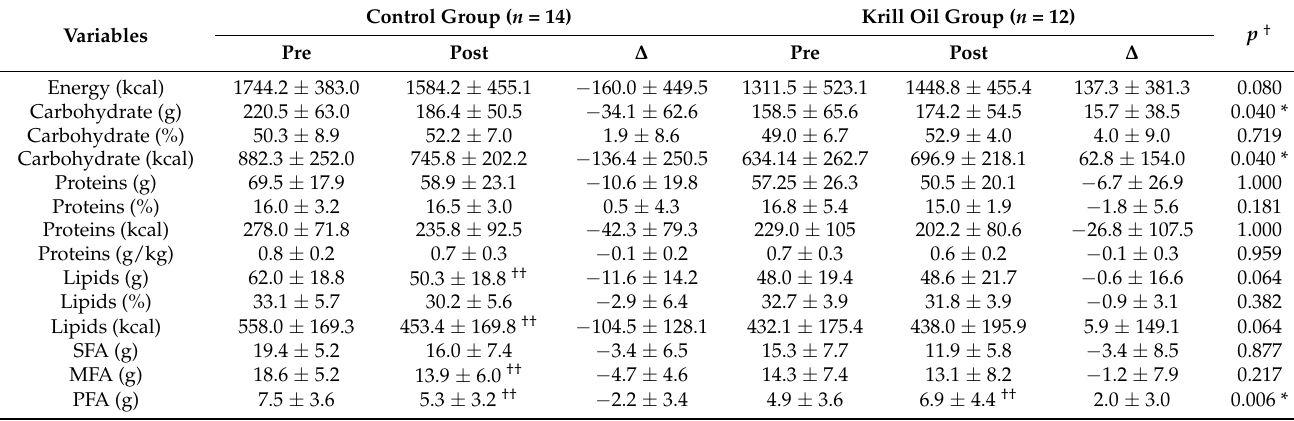
Table 2. Total food consumption of the